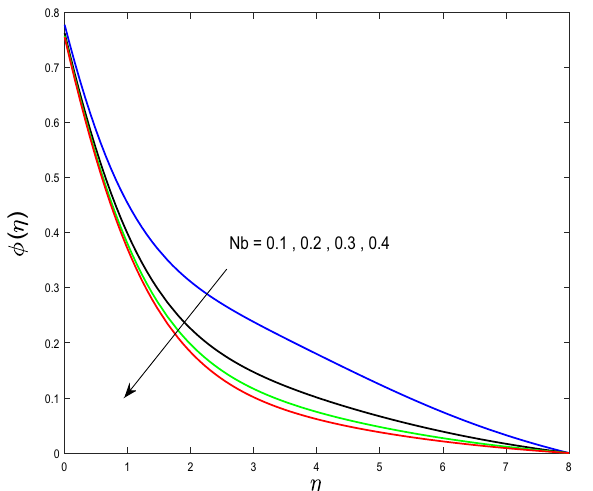
Figure 17. Plot of φ for Nb .